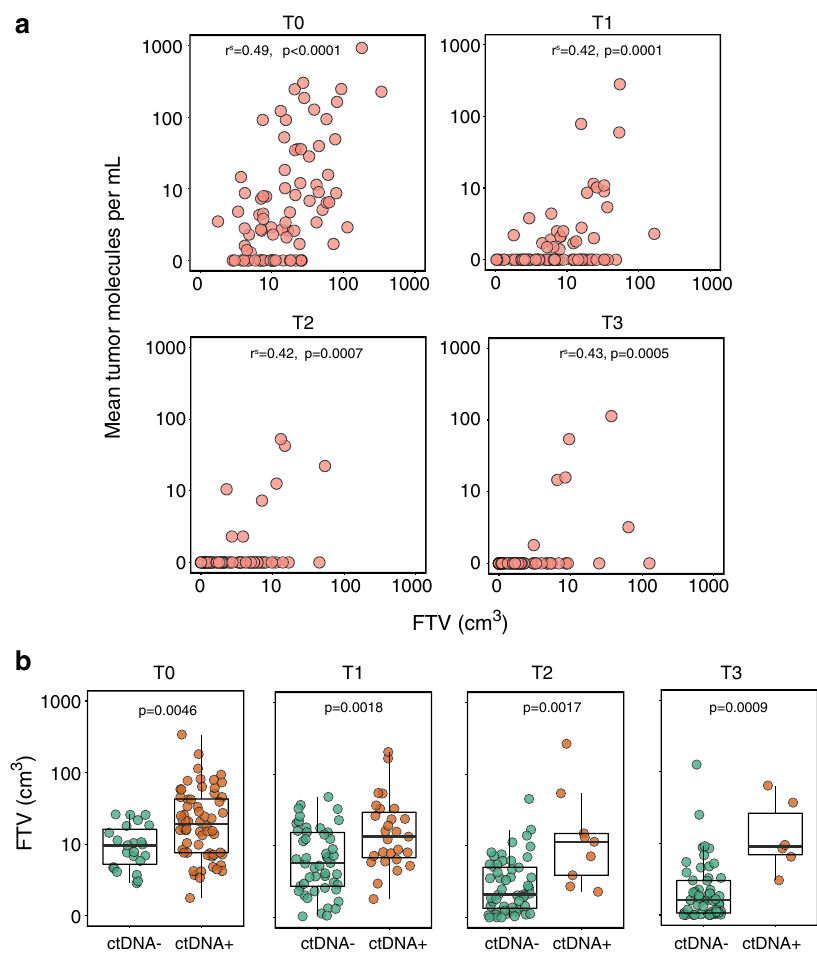
Fig. 2 Relationship between ctDNA and FTV at different time points. a Scatterplot for all patients with paired data at different time points to show correlation between ctDNA and MRI-based FTV as measures of tumor burden. b ctDNA-positivity and tumor burden by MRI-based FTV. Box plots showing distribution of FTV according to ctDNA status (ctDNA-positive or ctDNA-negative) at different time points. T0: pretreatment; T1: 3 weeks after initiation of paclitaxel-based treatment; T2: between paclitaxel and anthracycline regimens; T3: after NAC prior to surgery. For each box plot, the center line, the boundaries of the box, the ends of the whiskers and points beyond the whiskers represent the median value, the interquartile range, the minimum and maximum values, and the outliers, respectively.